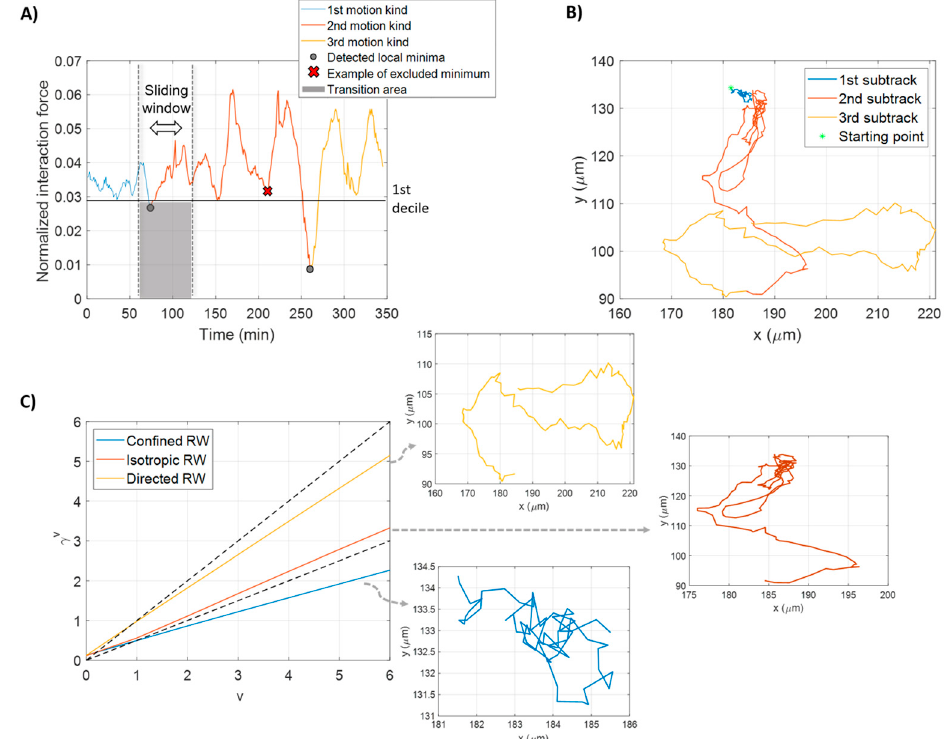
Figure 3. Motility switches detection and motion kind assignment. ( A ) Normalized interaction force exerted by cells in a cluster on a cell belonging to the same cluster. Switches from a mode of motion to another (shown in three diverse colors) match the detected local minima of the force (gray circles), which are located in the transition area (shaded gray area) between the sliding window and the first decile. Minima intercepted by the sliding window, but over the first decile are excluded (red cross). ( B ) The resulting cell trajectory divided in three di ff erent-colored sub-tracks corresponding to the three parts obtained by the identification of the local minima in ( A ). The green asterisk denotes the starting point of cell trajectory. ( C ) MSS computation for the three sub-tracks in ( B ) with representation of each sub-track. The slope of the MSS defines the motion kind assignment: 0.3561 for confined random walk (light blue), 0.5432 for isotropic random walk (red) and 0.8368 for random walk with drift (yellow). RW in the legend stands for random walk. Dotted lines with slopes of 1 and 0.5 are also represented as